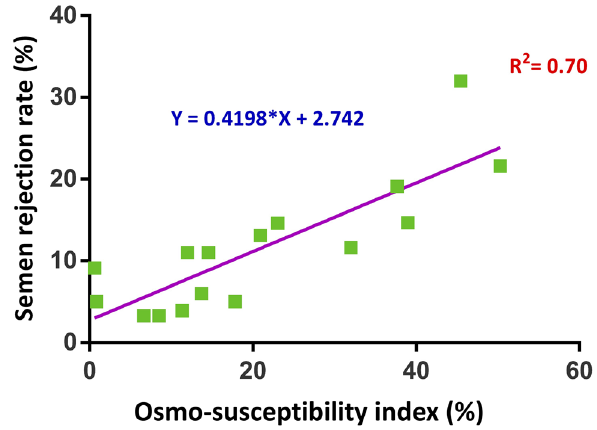
Figure 5. Relationship between the ejaculate rejection rate with osmo-susceptibility index. The coefficient of determination of the regression equation (R 2 ) was